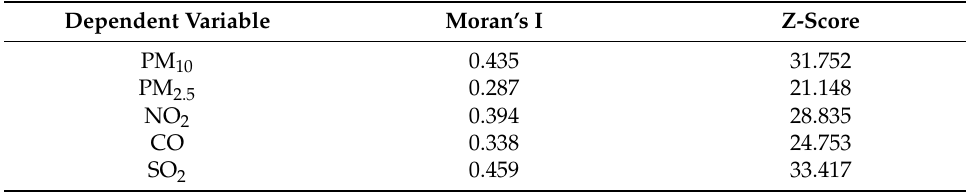
Table 2. Results of the spatial autocorrelation